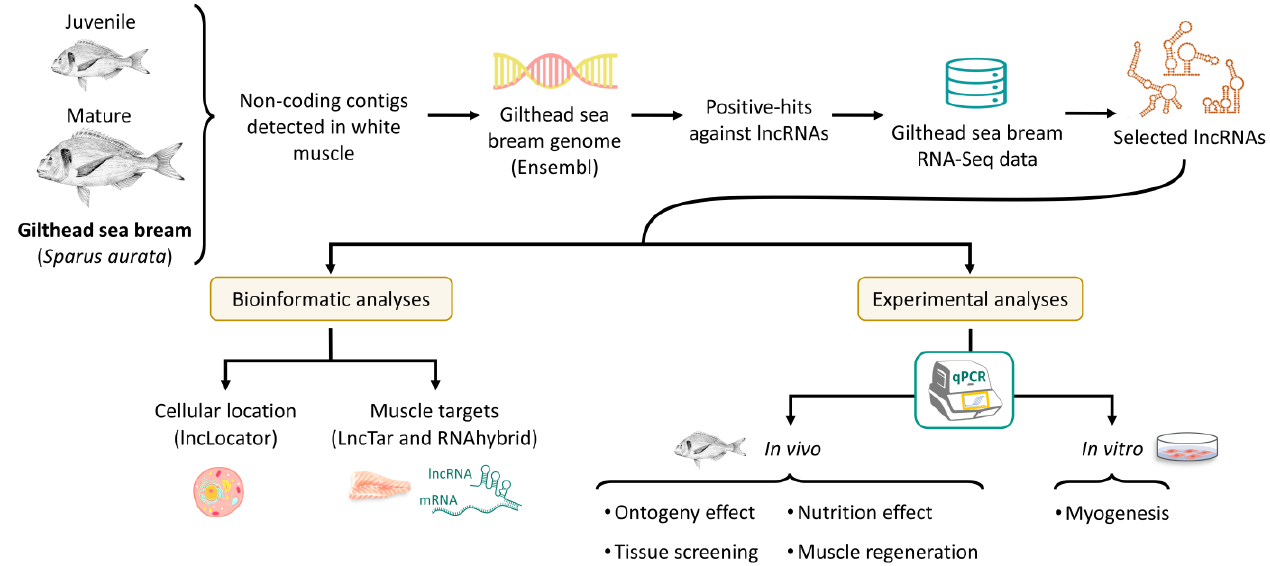
Figure 1. Workflow for the detection and analysis of gilthead sea bream fast skeletal muscle lncRNAs. Gilthead sea bream figure was extracted from https://www.fao.org/fishery/culturedspecies/Sparus_ aurata/es (accessed on 15 November